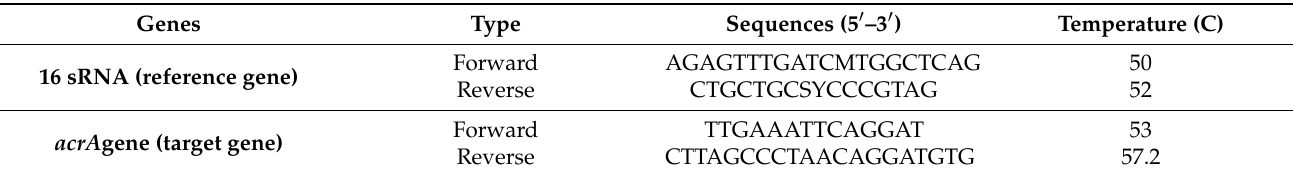
Table 6. The primer sequences for the real time qPCR